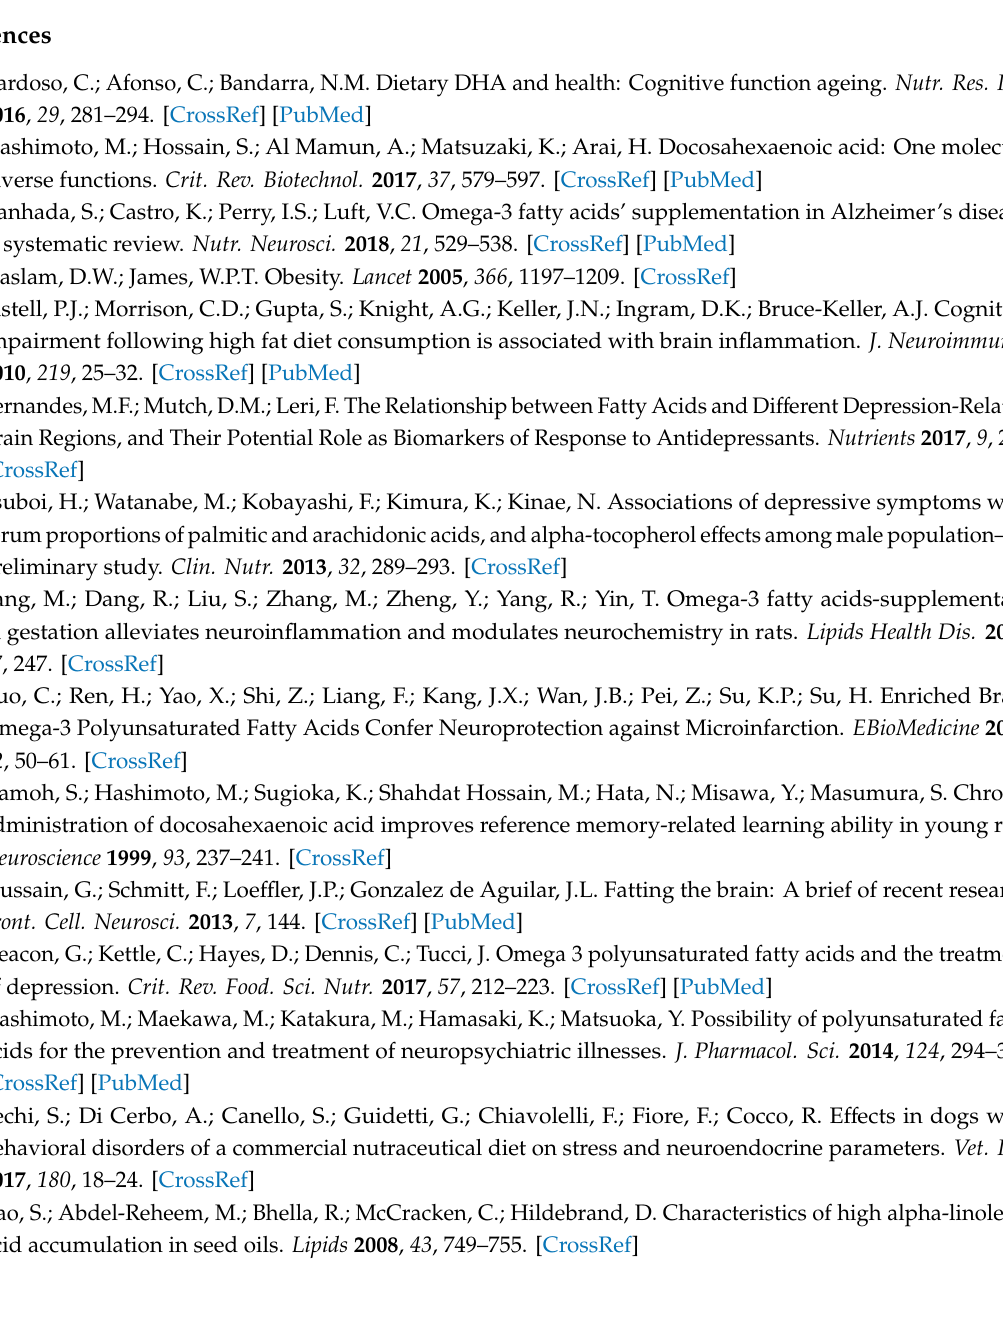
Figure S1: The di ff erences between male and female in ∆ -SDS score from baseline to 12 months in the PO and placebo